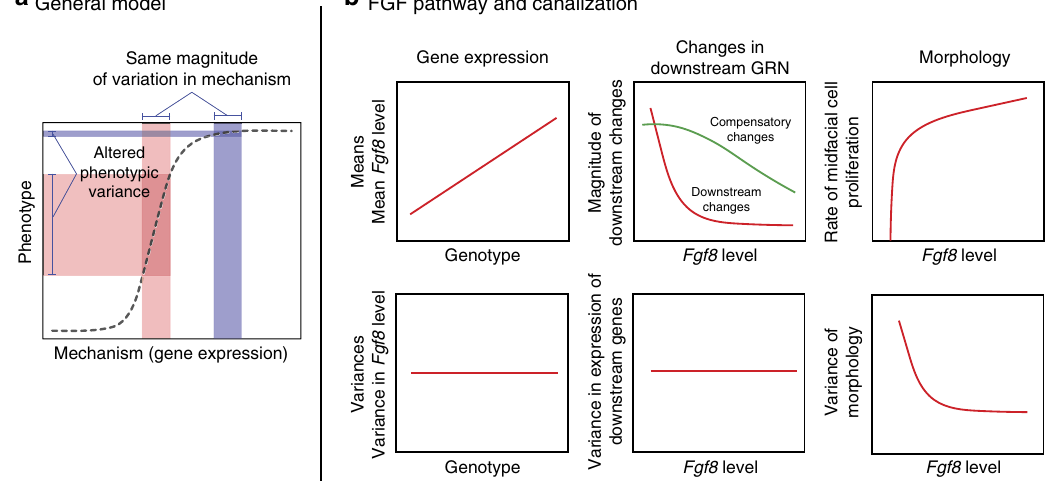
Fig. 1 Nonlinearities at multiple levels across development modulate variance. a General model of a nonlinear genotype – phenotype map where the amount of a particular developmental process (e.g., cell survival, proliferation, and Fgf signaling) determines mean phenotype. Note that the same amount of variation in the mechanism ( “ wild-type ” gene expression — blue vertical bar, “ mutant ” gene expression — red vertical bar) can generate vastly different amounts of phenotypic variation. This model yields a canalized region where variance is buffered ( “ wild-type ” shape variation, blue horizontal bar) and an area where canalization is lost ( “ mutant ” shape variation, red horizontal bar). b Hypothetical model of how nonlinear genotype – phenotype relationships are generated at multiple biological levels. The top left panel shows that gene expression will relate linearly to cranial phenotype. The top mid panel shows that changes in the gene regulatory network (GRN) downstream to Fgf8 respond either nonlinearly, driving change in the phenotypic mean (red line), or act in a compensatory manner, buffering the effect of variation in Fgf8 (green line). The top right panel shows that morphology will relate nonlinearly to Fgf8 level, potentially due to nonlinear changes in the underlying cell biological processes. Variances are in fl uenced at the level at which the nonlinearity